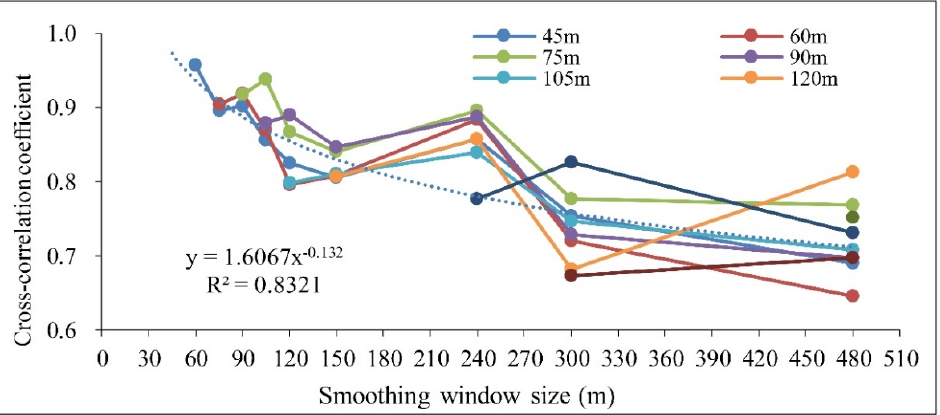
Figure 5. The variation trends of the cross-correlation coefficient for the HSSE calculated under the specified smoothing window sizes of 45 m, 60 m, 75 m, 90 m, 105 m, 120 m, 150 m, 240 m, and 300 m.